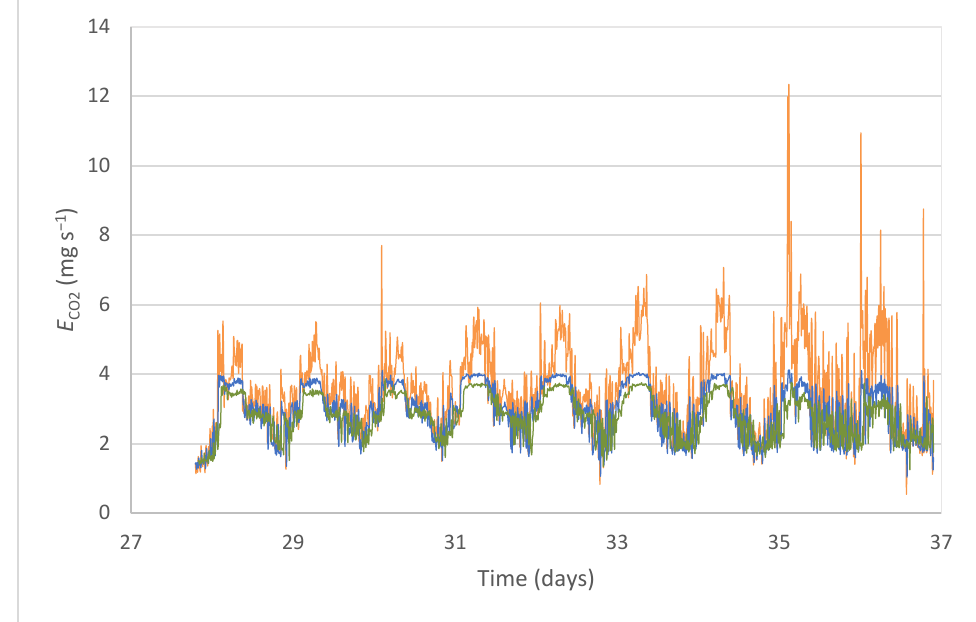
Figure 6. Measured ( − ) and predicted values of CO 2 emission per animal, for a 10 min period ( − ) and a 60 min period ( − ), during the trial stage.